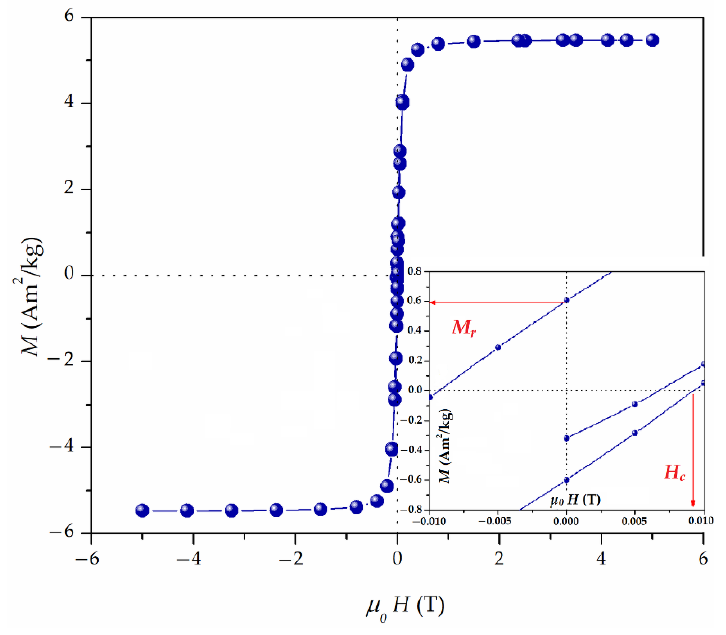
Figure 4. Magnetization curve at 300 K and ±5 T of Fe 3 O 4 @APTMS/PGME-deta. Inset: Magnified view of magnetization curve near the origin.